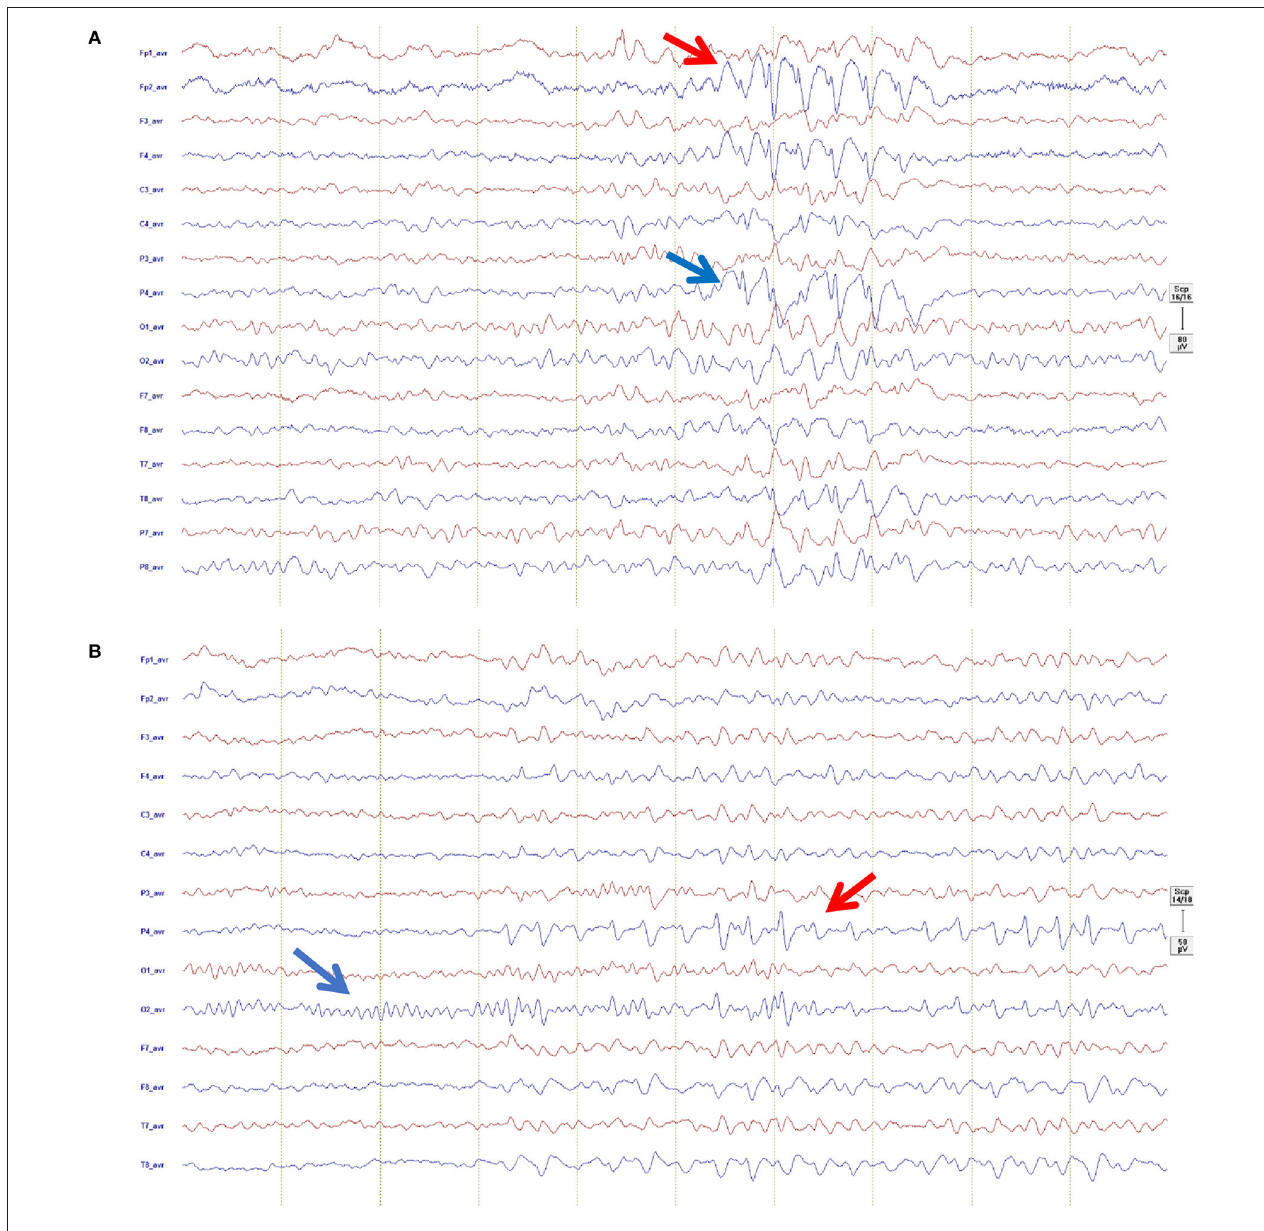
FIGURE 2 | Representative EEG recordings from possible OAE epilepsy cases: (A) Shown in an average montage (left channels red, right channels blue, Filter 0.53–83Hz, sensitivity 80 µ /cm, 1 sek/30mm), showing focal epileptiform activity in form of spike-wave predominantly right frontal (red arrow) propagating to right parietal (blue arrow): (B) Shown in an average montage (left channels red, right channels blue, Filter 1.59–20Hz, sensitivity 80 µ /cm, 1 sek/30mm), showing normal posterior dominant rhythm (blue arrow) and train of right sided focal epileptiform activity in form of sharp-slow-wave predominantly in the right parietal region (red